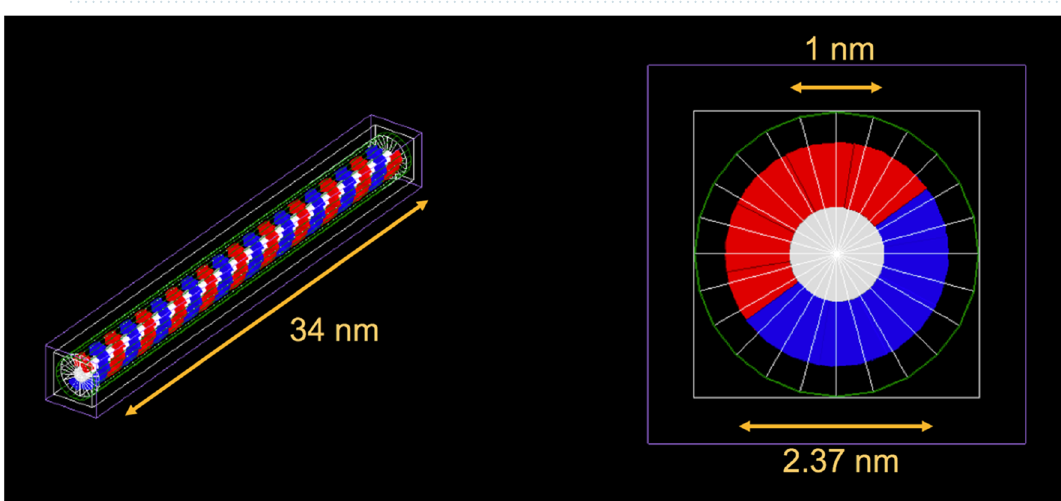
Table 1. Dose calculations for the administered 18 F activities as determined from experimental (analytical) and in silico data (OLINDA/EXM).